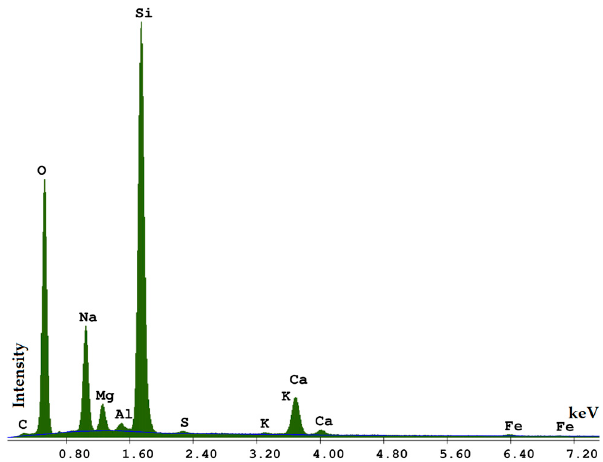
Figure 2. EDS of packaging glass .